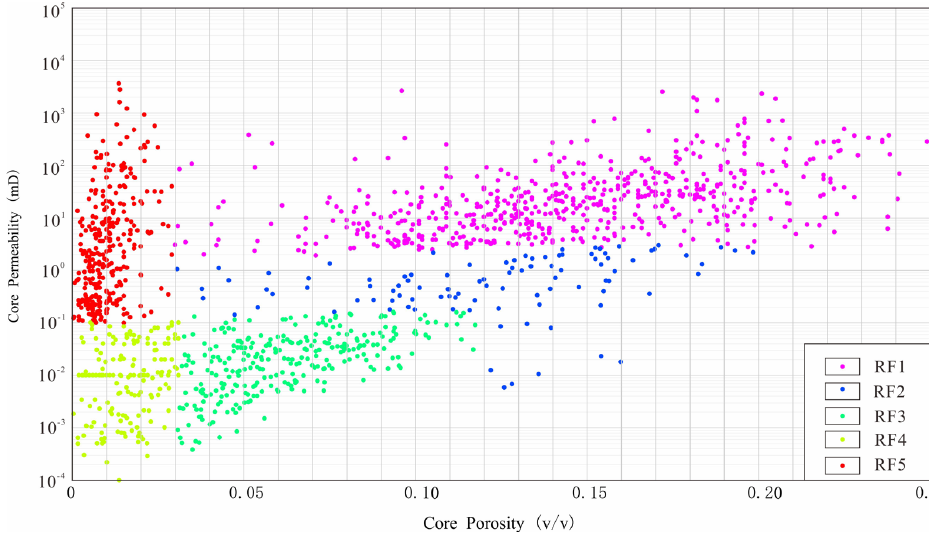
Figure 10. Porosity − Permeability cross plots of reservoir facies of the Callovian − Oxfordian stage. As depicted in Figure 10 and Table 3, From RF1 to RF4, the average porosity, perme- Table 3. Statistical parameters calculated for reservoir facies (RFS) of the Callovian − Oxfordian stage. ability, and RQI gradually decrease, indicating that the reservoir storage capacity and flow capacity gradually decrease, and the reservoir quality gradually deteriorates. An